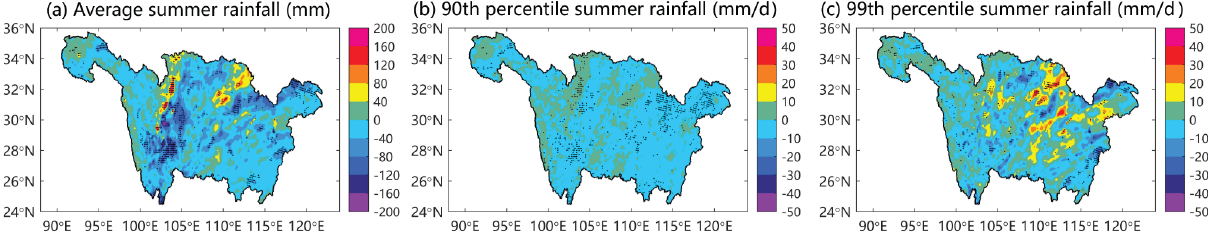
Figure 7. The changes in (a) average summer rainfall (mm), (b) 90th percentile summer rainfall (mmd − 1 ), and (c) 99th percentile summer rainfall (mmd − 1 ) between the 2010 scenario and 1990 scenario. The stippled regions show statistical significance of the changes identified by the t test at a 5% significance level.